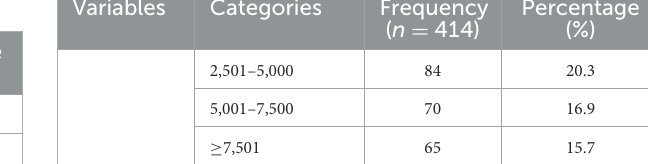
TABLE 1 Socio-economic distributions among primary caregivers of adult patients with mental illness attending at Harari region state public hospitals, Eastern Ethiopia, 2022 ( n =